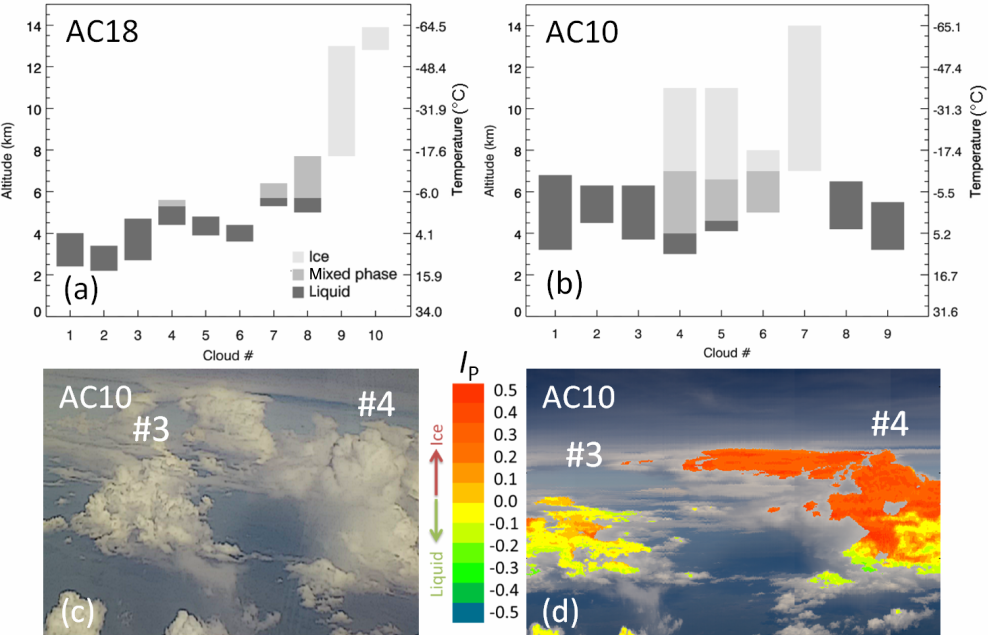
Figure 10. (a) Phase classification of studied clouds based on specMACS observations during flight AC18. (b) Same as (a) but for AC10. (c) GoPro image of cloud scene during AC10. (d) Phase index as derived from specMACS during AC10 for illustrated clouds from (c)